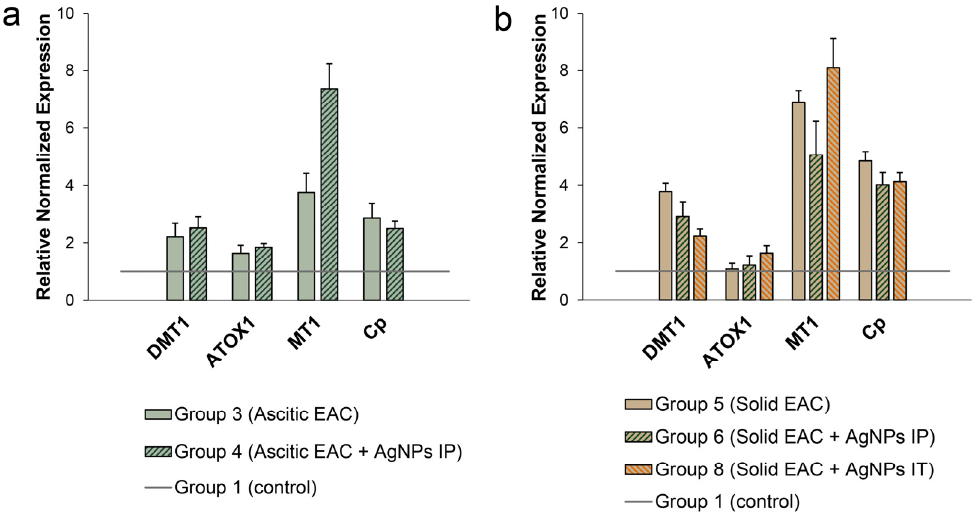
Figure 10. Expression level of the genes responsible for serum copper status in the liver of mice bearing EAC. ( a ) Mice with growing ascitic EAC treated with AgNPs IP; ( b ) mice bearing solid EAC treated with AgNPs IP or IT.